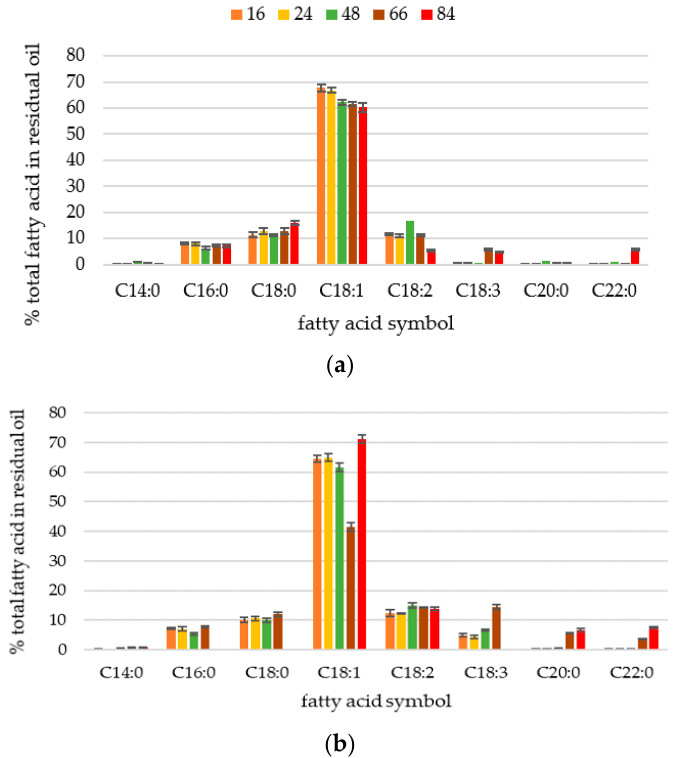
Figure 6. Profile of fatty acids in residual carbon source during fed-batch cultures of Y. lipolytica yeast cells grown in MO5 ( a ) and MO5-2xN ( b ) medium. The error bars indicate standard deviation.